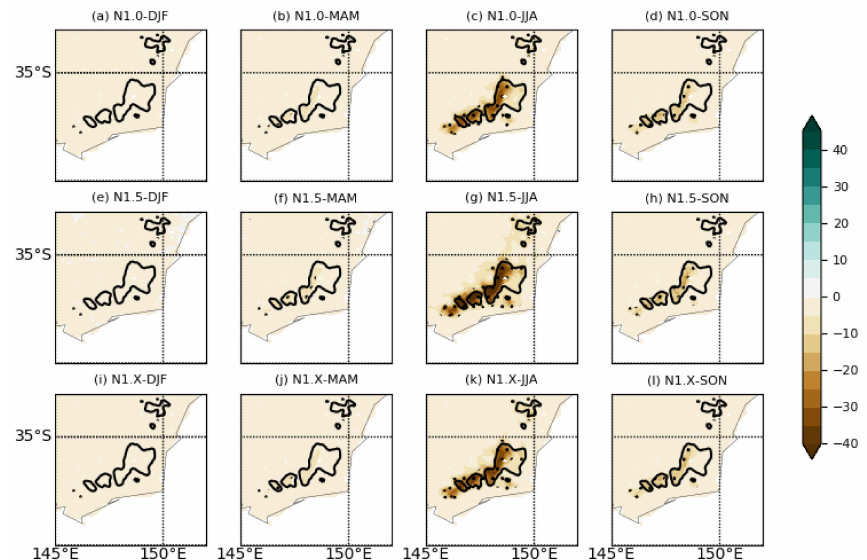
Figure 9. Future changes in mean seasonal albedo for 2060–2079 relative to 1990–2009 for N1.0, N1.5 and N1.x. Stippling indicates statistically significant changes using a non-parametric Mann-Kendall test at the 95% confidence level. The black solid lines are the 1200 m contour where the high elevation areas